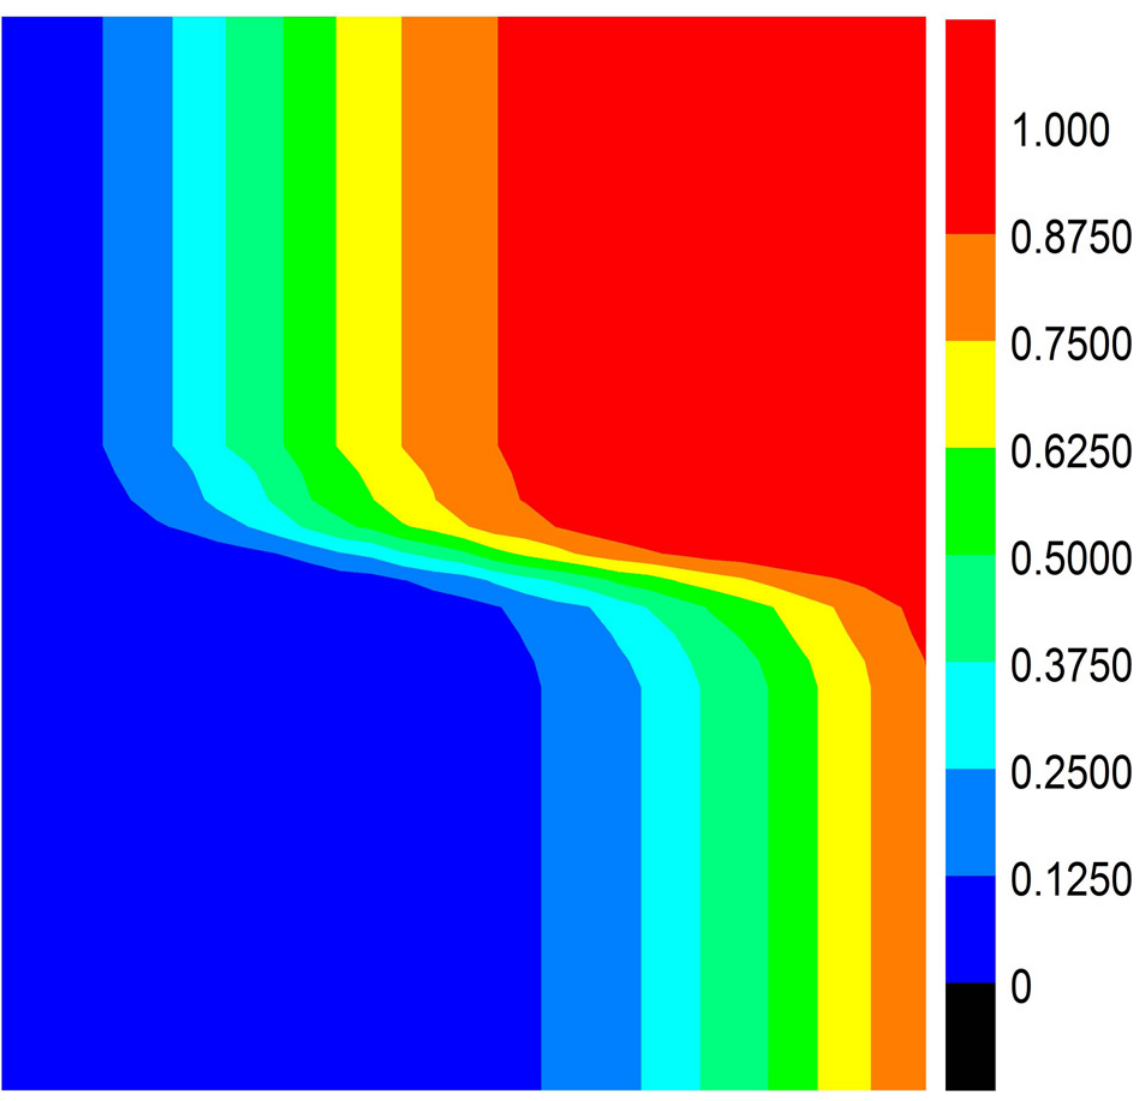
Fig 7. Relationship between the fraction of behavior 1 in the population and two variables, namely, f and q . The game parameters used in this figure are the same with those in Fig.